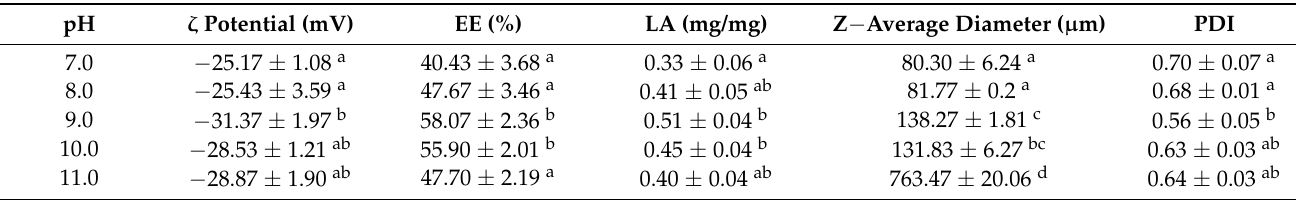
Table 1. Characteristics of the microcapsule under different emulsifying pH.